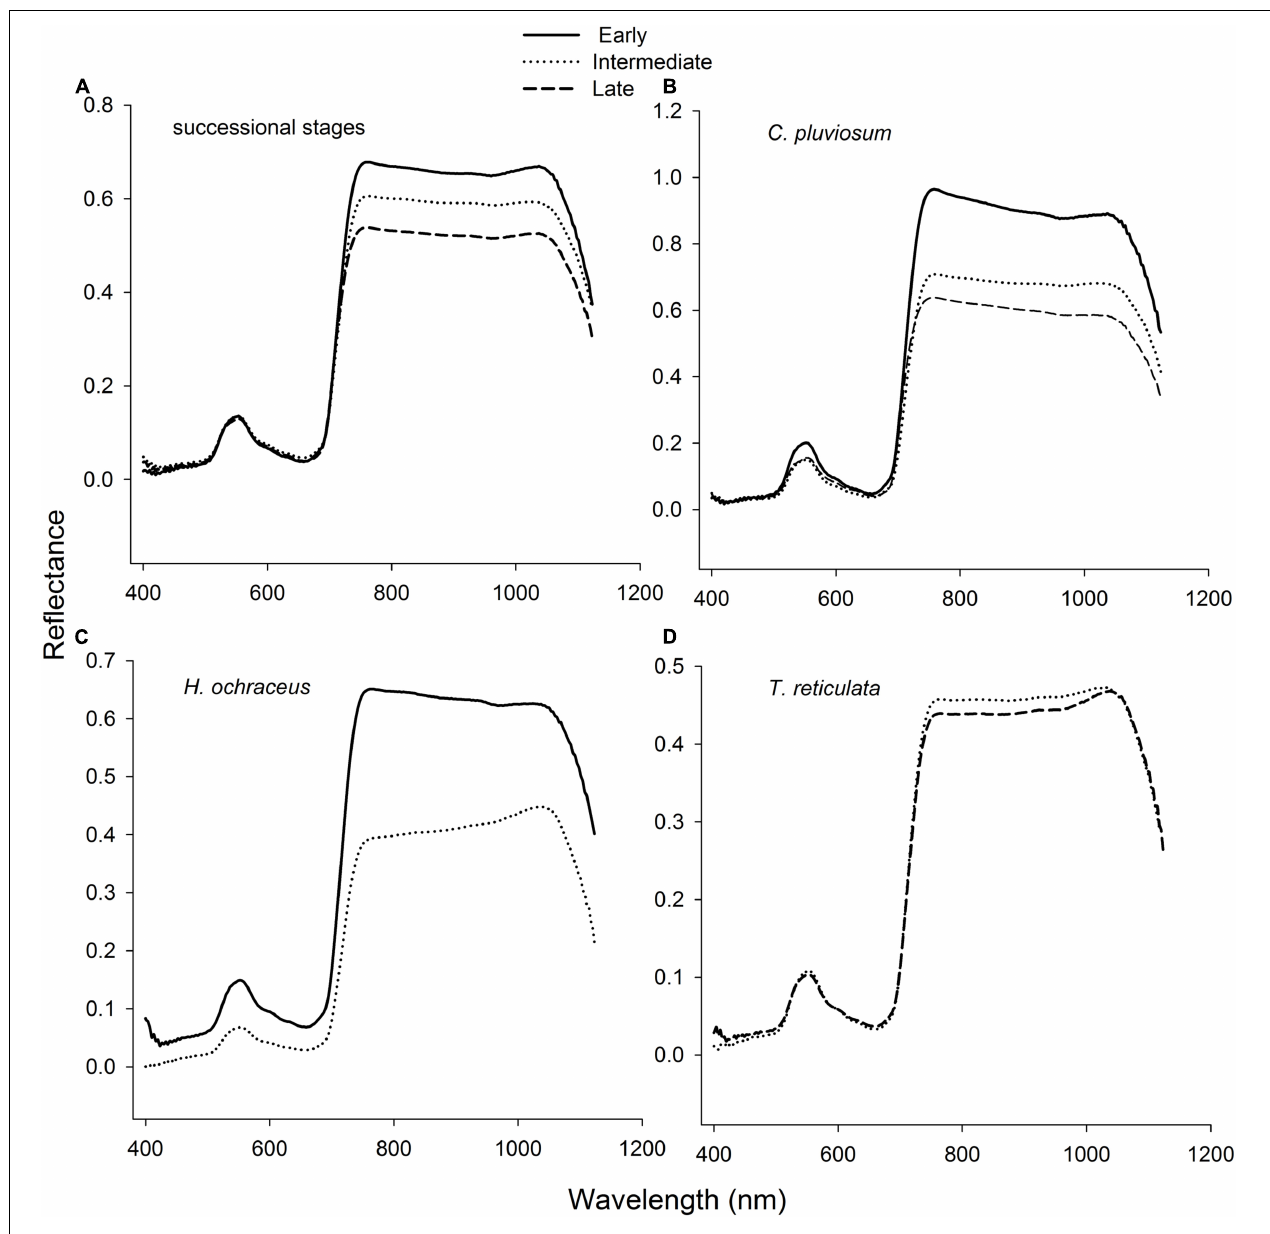
FIGURE 2 | (A) Mean leaf reflectance spectra for (A) all three species together, and for each species separately (B–D) in different successional stages in a tropical dry forest.